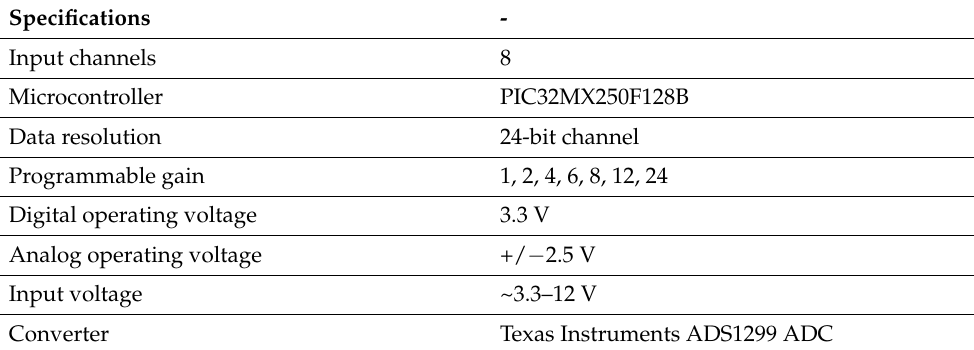
Table 1. Hardware specification of OpenBCI 32 bit Board (Open BCI, Brooklyn, New York, NY, USA).